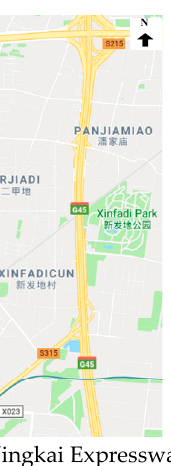
Figure 4. Experimental road section. ( a ) Jingkai Expressway; ( b ) Jingkai Expressway grid topology built with VISSIM.